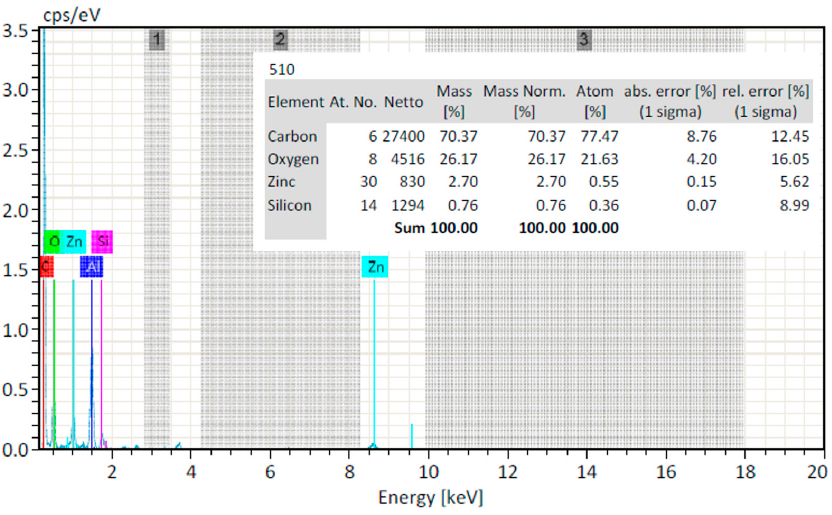
Figure 5. EDX analysis of ZnO NPs.